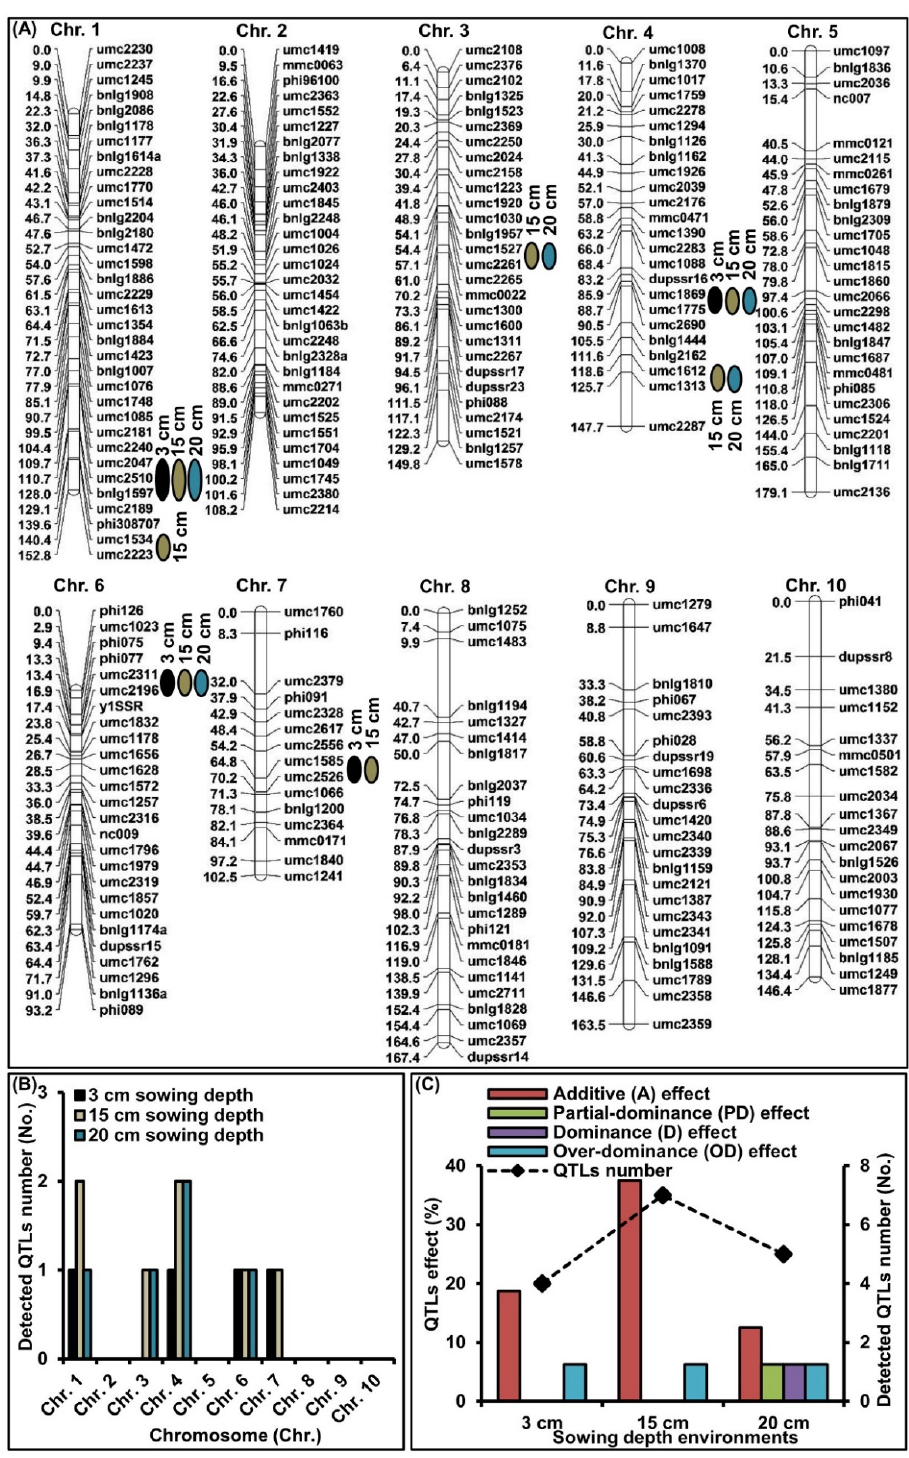
Figure 3. Genetic linkage map based on the F 2 population and QTLs detected for mesocotyl length (MES) in the F 2:3 population via single-environment mapping, with composite interval mapping (CIM) under 3 cm, 15 cm, and 20 cm sowing environments, respectively. ( A ) Location of detected QTLs for MES on the genetic map. ( B ) Distribution of detected QTLs on ten chromosomes. ( C ) Gene action analysis of detected QTLs.